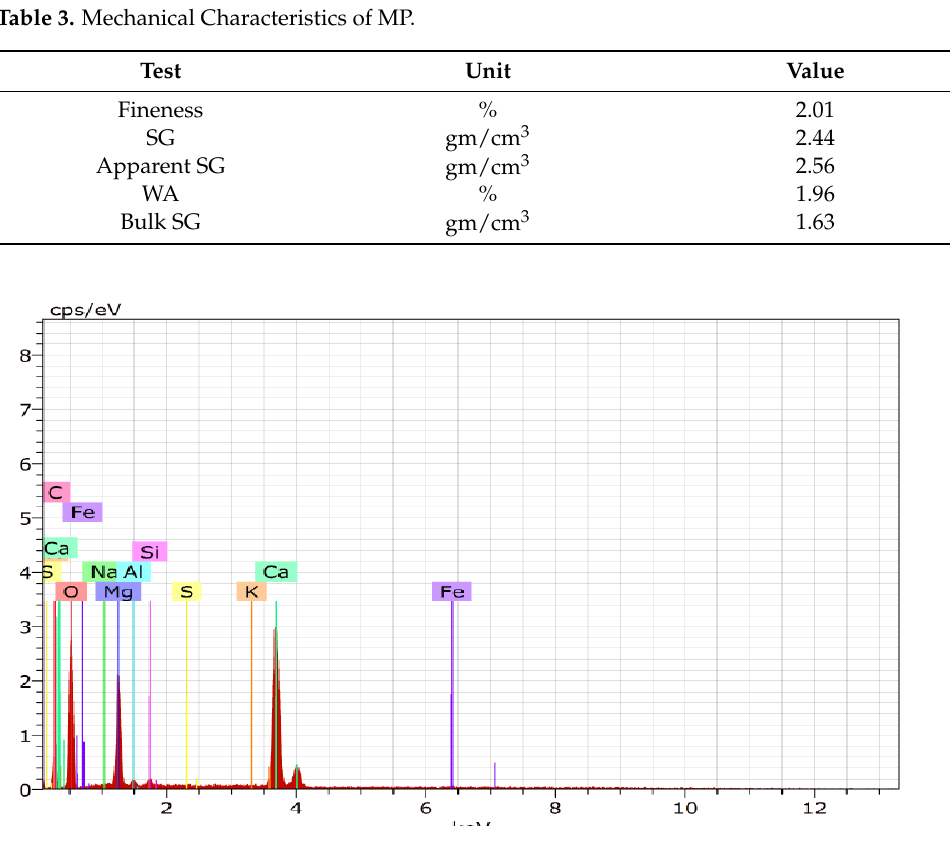
Table 2. Mechanical Characteristics of cement.